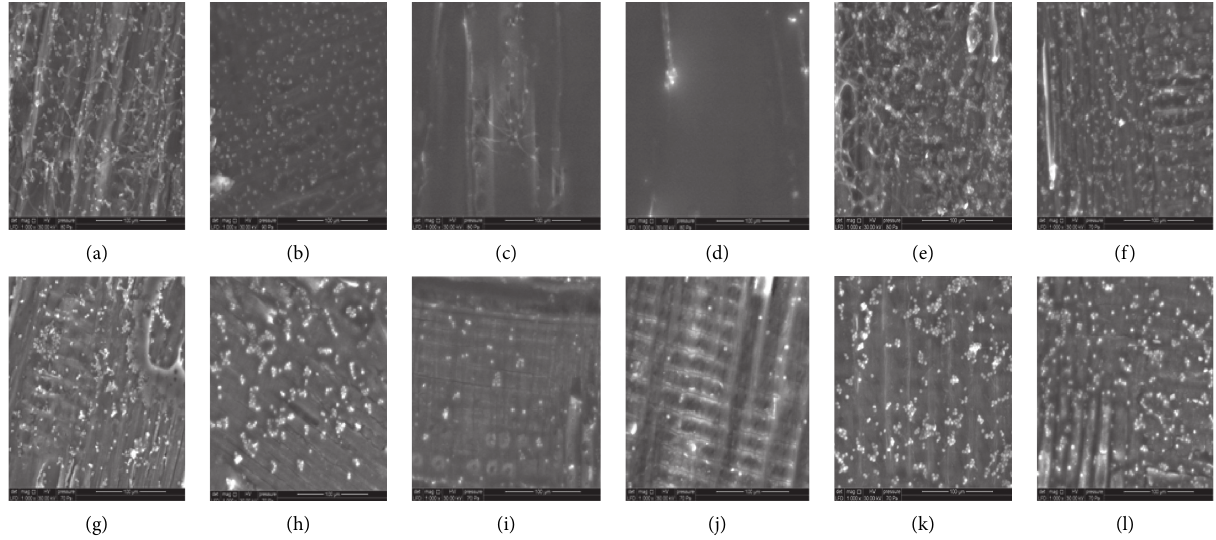
Figure 2: Electron micrographs of Penicillium commune (PDLd10) (a–f) and Aspergillus niger (g–l) spores adhered on to untreated and treated wood, visualized by environmental scanning electron microscopy. (a, g) untreated wood, (b, h) olive oil treatment, (c, i) sunflower oil treatment, (d, j) rapeseed oil treatment, (e, k) linseed oil treatment, and (f, l) argan oil